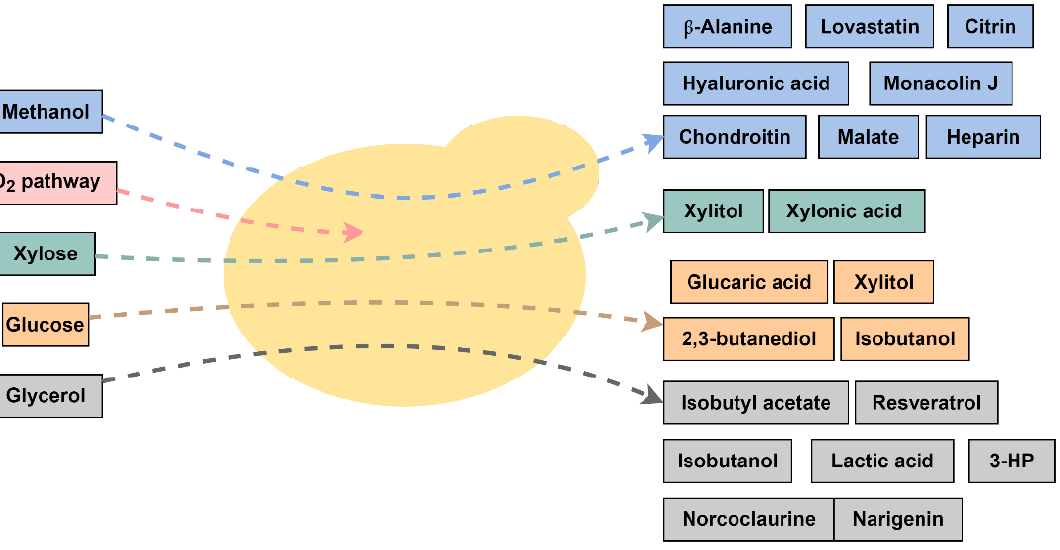
Figure 1. Representative scheme of the different carbon sources and chemicals produced by engi- neered K. phaffii strains. 3-HP = 3-hydroxy propionic acid.